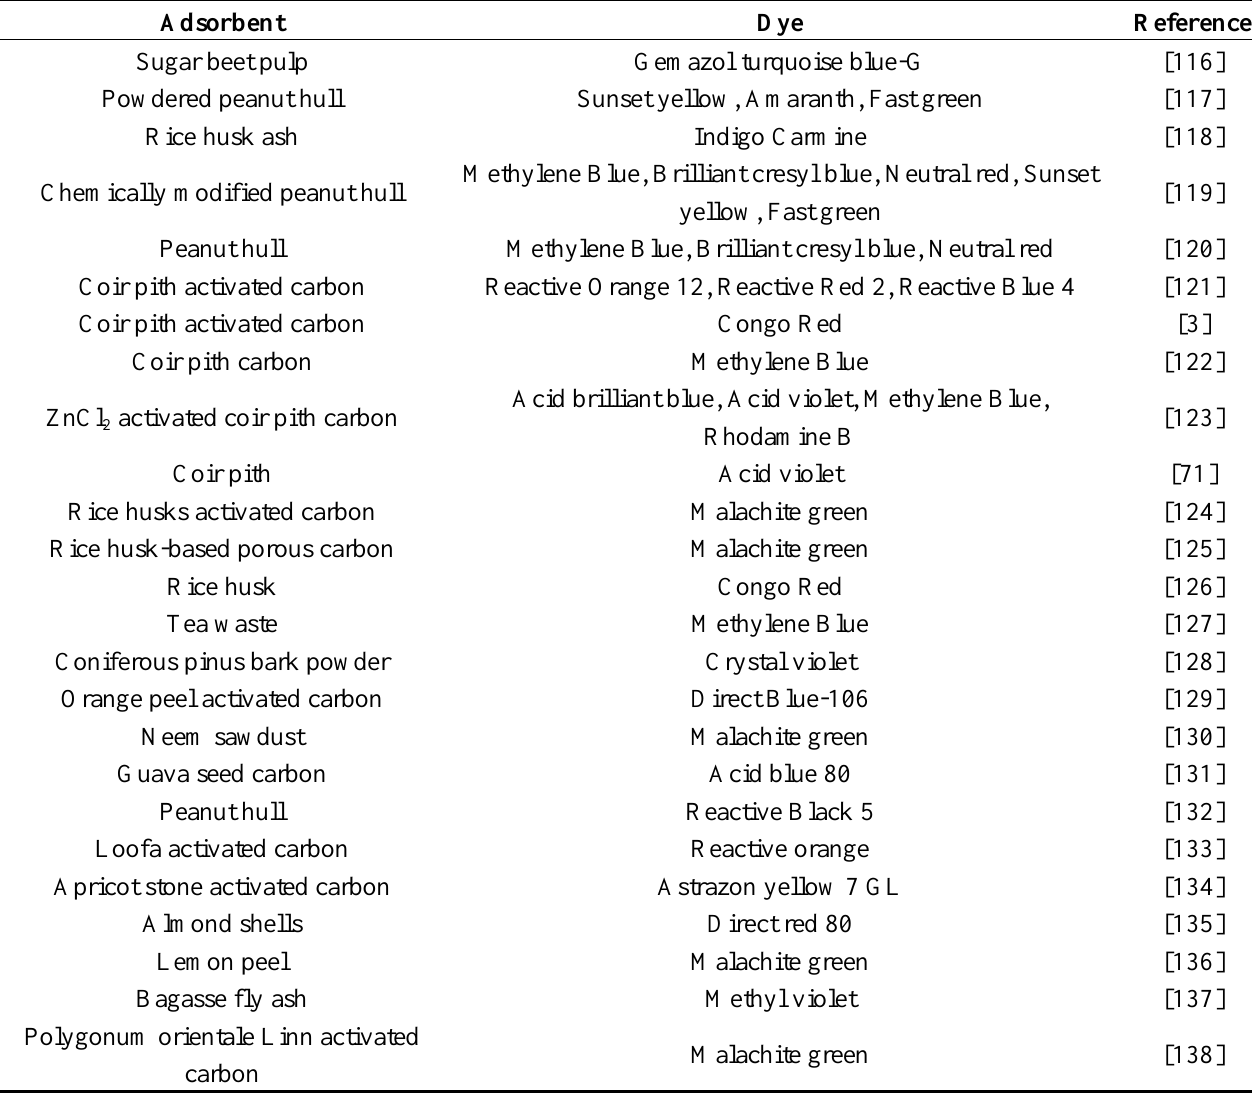
Table 1. Previous studies of the adsorption of dyes using adsorbents based on agricultural solid